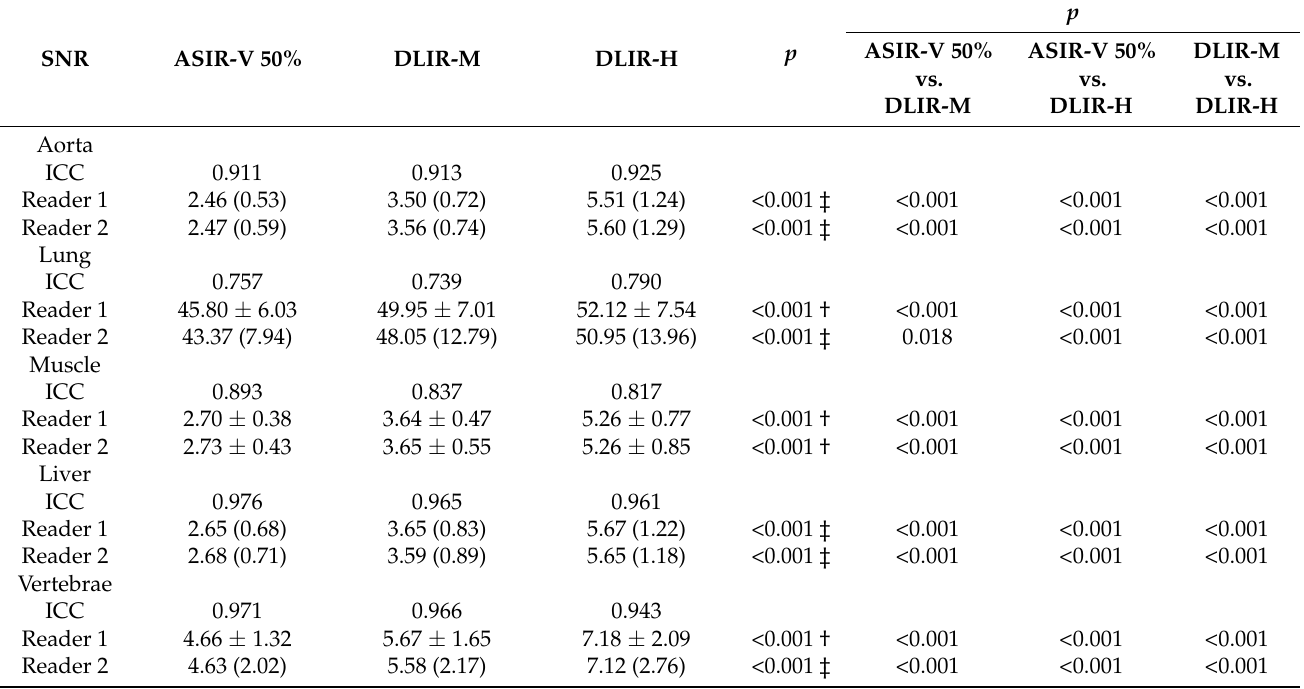
Table 3. Comparison of SNR among the three groups.